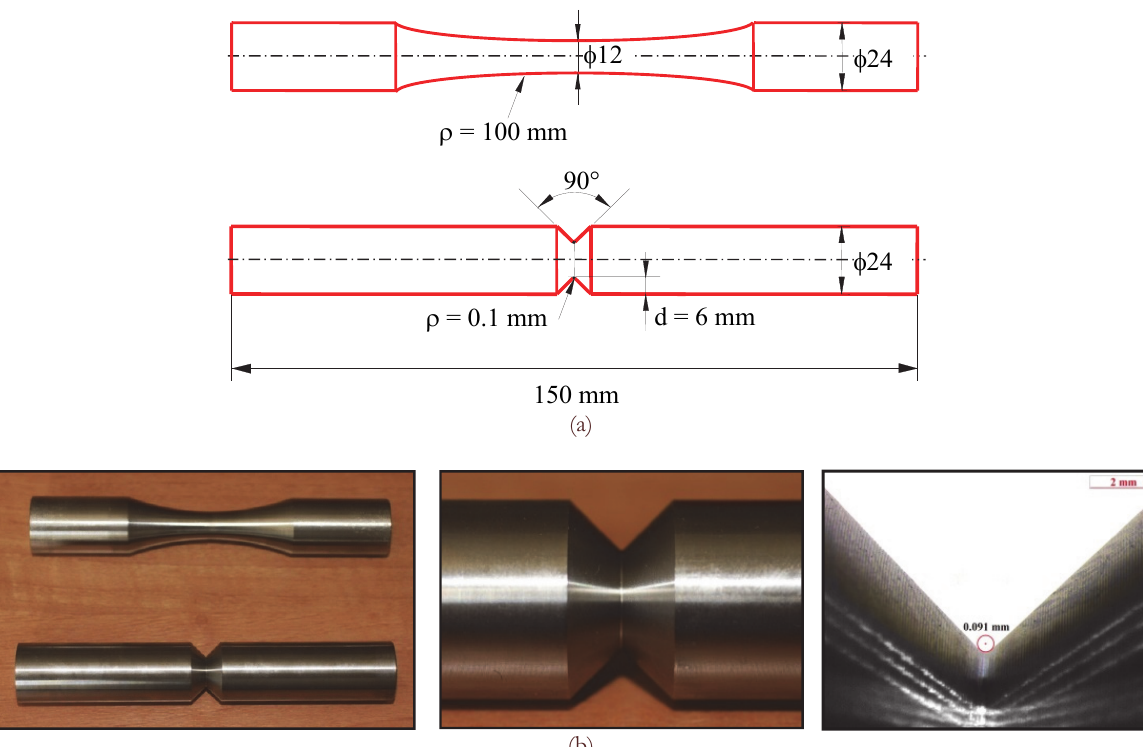
Figure 1: (a) Geometries of smooth and sharply notched specimens and (b) examples of tested